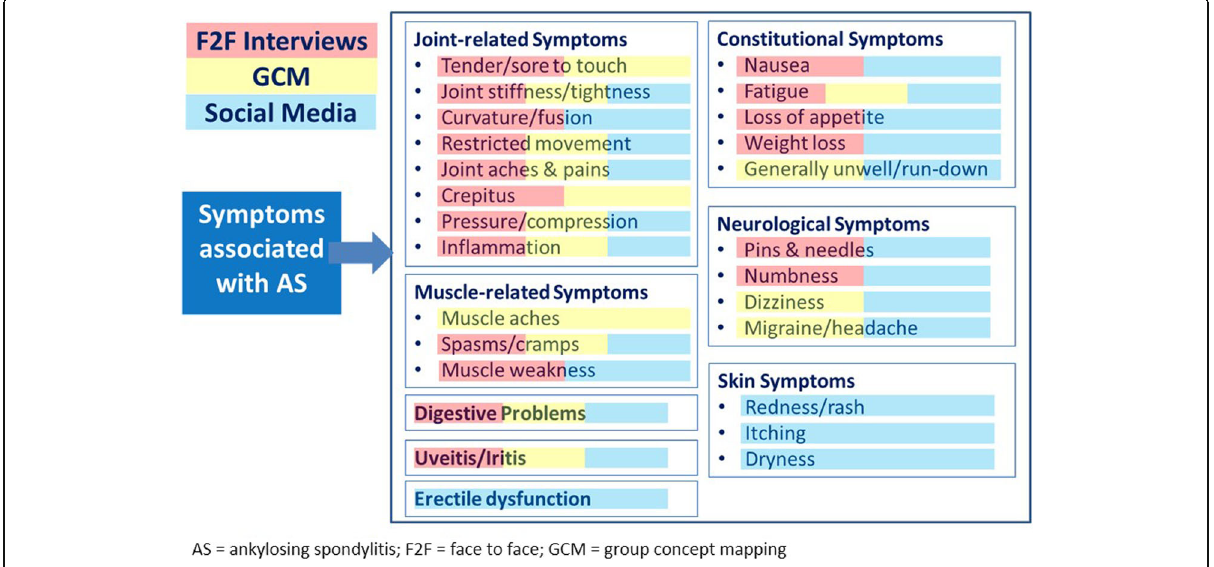
Fig. 2 A combined conceptual model of AS symptoms identified based on all three